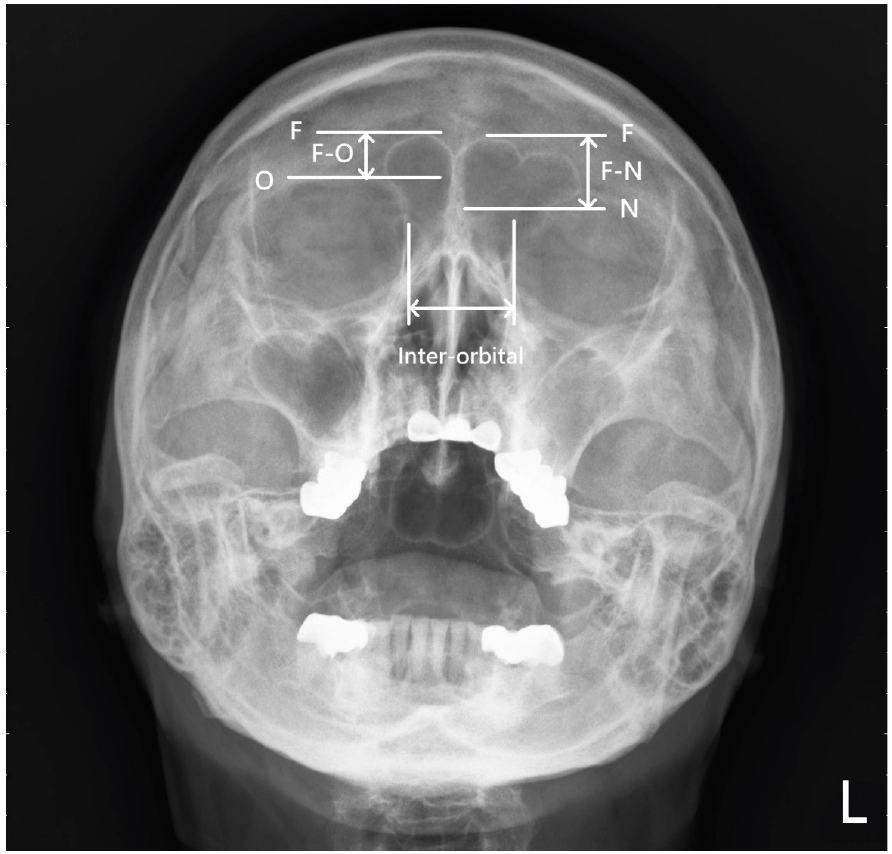
Figure 2. The definition of the frontal sinus roof ‒ supraorbital margin (F-O), frontal sinus roof ‒ nasion (F-N), and inter-orbital distance.